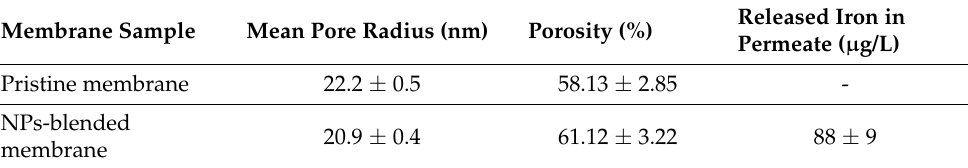
Table 2. Effect of NPs amount on the mean pore size and porosity properties.